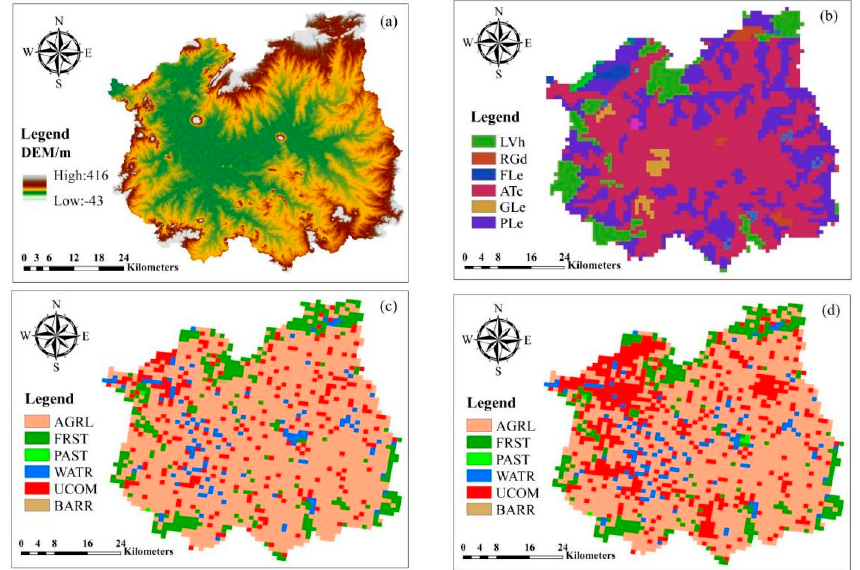
Figure 2. The characteristics of ( a ) the digital elevation map (DEM), ( b ) the distribution of soil, ( c ) land use in 1980, and ( d ) land use in 2015 (LVh, haplic luvisols; RGd, dystric regosols; FLe, eutric fluvisols; ATc, cumulic anthrosols; GLe, eutric gleysols; PLe, eutric planosols; AGRL, agricultural land; FRST, forest; PAST, pasture; WATR, water; UCOM, urban commercial land; and BARR, barren land).